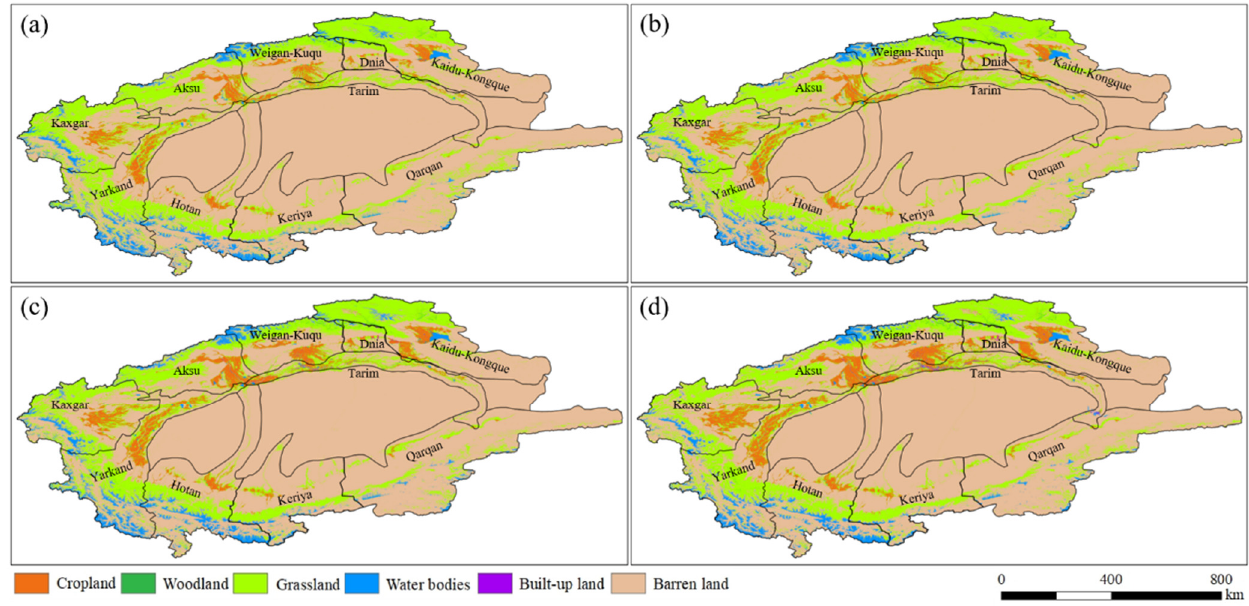
Figure 3. Land uses in the Tarim River Basin from 1990 to 2019: ( a ) 1990; ( b ) 2000; ( c ) 2010; and ( d ) 2019.